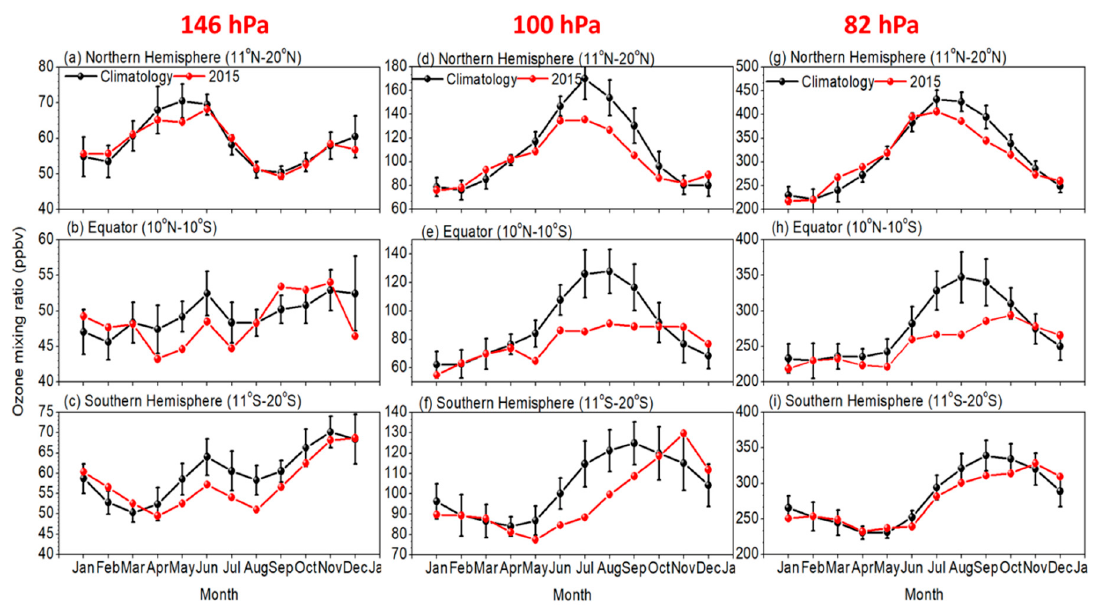
Figure 2. Annual cycle of ozone mixing ratio observed at 146 hPa ( a – c ), 100 hPa ( d – f ) and at 82 hPa ( g – i ) averaged over different latitude bands. Black colour line shows monthly climatology of ozone mixing ratio calculated by using MLS data from January 2006 to December 2017 and red colour line shows the monthly mean of ozone mixing ratio during 2015. Vertical bars indicate standard deviations of the measurements.